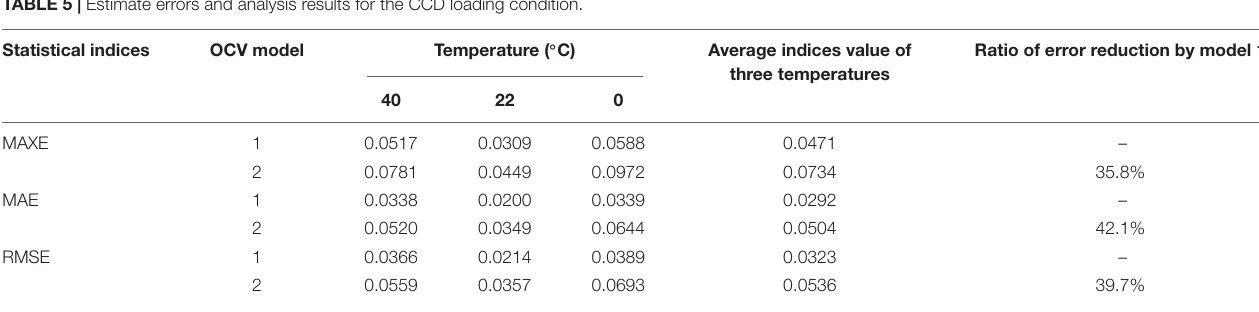
TABLE 5 | Estimate errors and analysis results for the CCD loading